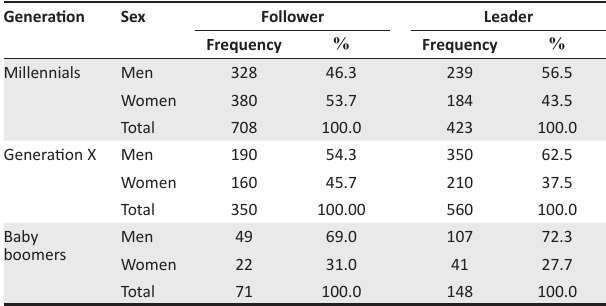
TABLE 3: Sex: Followers and leaders.